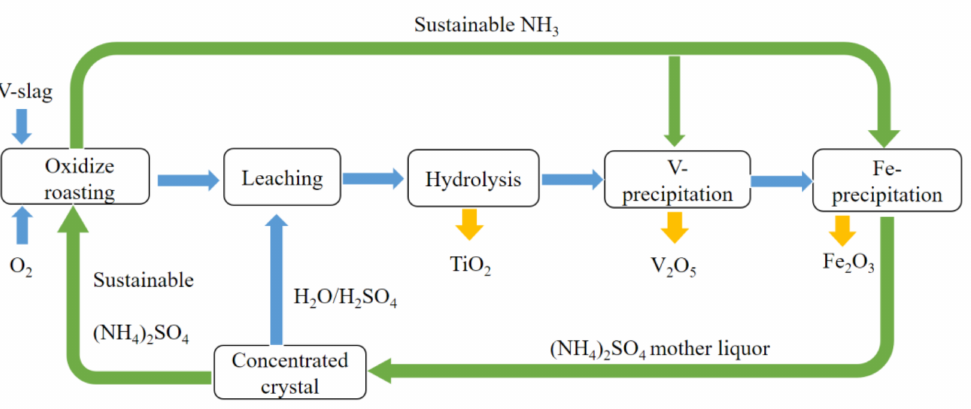
Figure 8. Sustainable recovery of vanadium and titanium via ammonium salt roasting